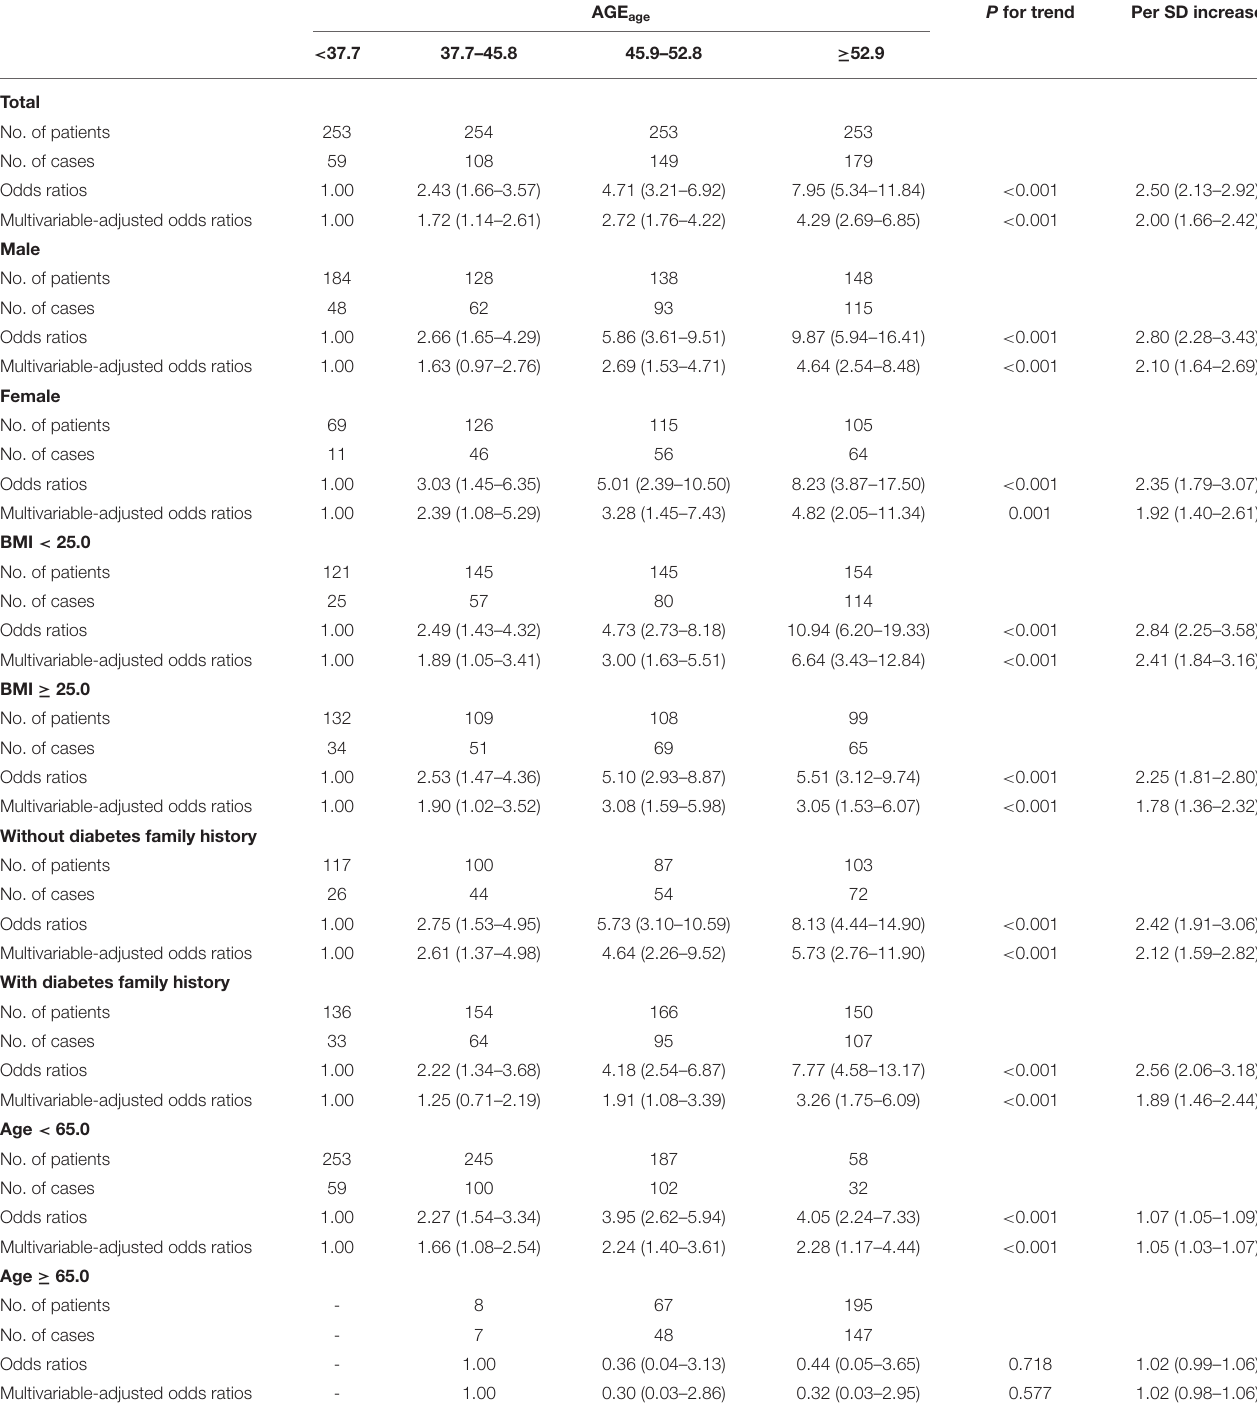
TABLE 2 | Association of AGE age with LEAD among patients with